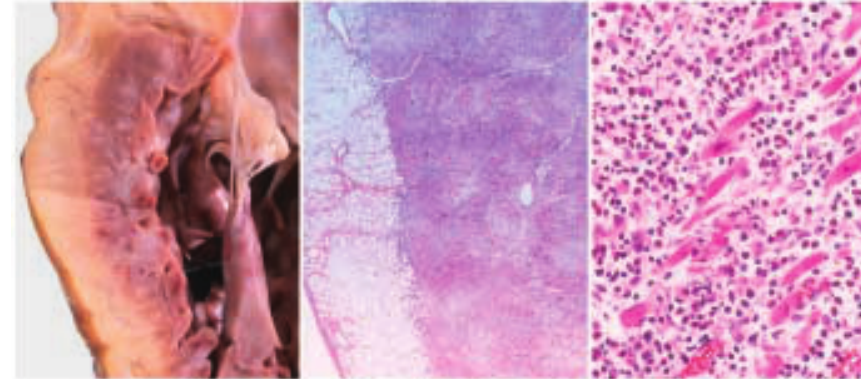
Microphotographs of experimental au- toimmune myocarditis in wild-type and gene-targeted mice – (a, b) IFN- g R –/– mice develop extensive patchy inflammatory infiltrates which include numerous eosinophils – (c, d) IL-4R –/– mice develop patchy inflammatory lesions infiltrating between and replacing cardiomyocytes – (e, f) IL-12p40 –/– mice are protected from myosin peptide-induced myocarditis and cellularity between myocytes is com- posed of vascular endothelial cells and tissue resident immune accessory cells – (g, h) myocarditis in wild-type BALB/c mice is shown for reference (haematox- illin-eosin staining, original magnifica- tions 30 (cid:2) and 400 (cid:2) ).